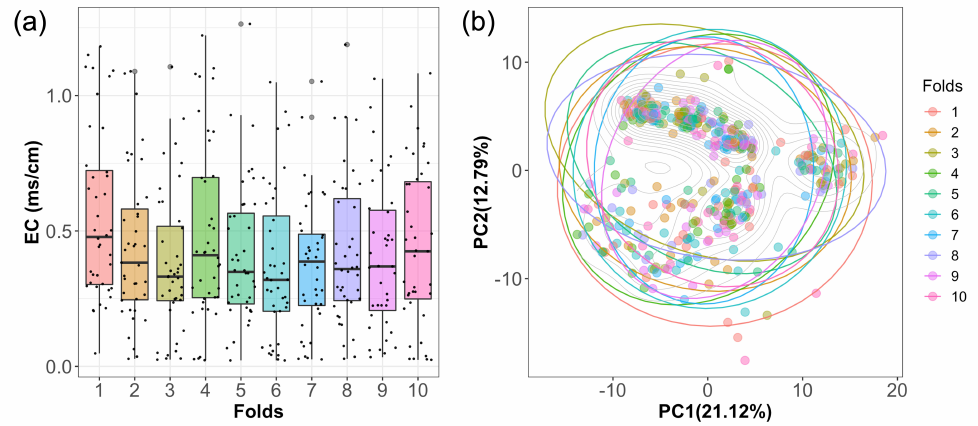
Figure 2. Boxplots of EC ( a ) and scatter plots of the scores of second principal component (PC2) against those of the first principal component (PC1) for soil reflectance spectra ( b ) from 10 folds. The ellipse is shown in 95%